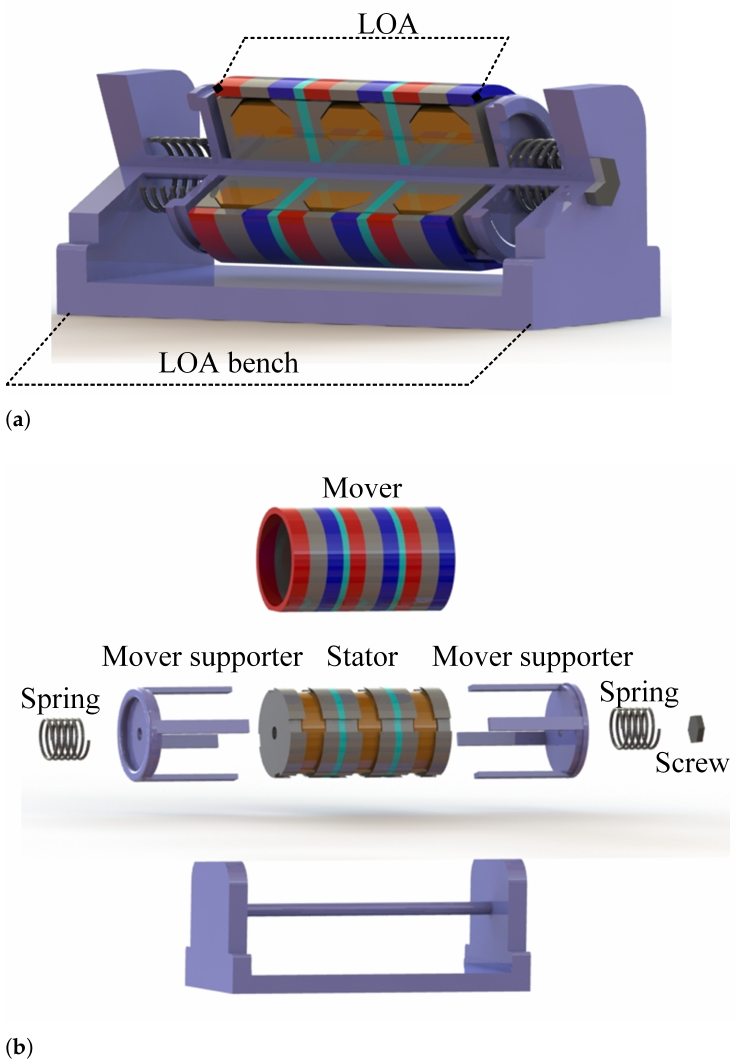
Figure 14. ( a ) Full assembly of the proposed TMM-LOA; and ( b ) exploded